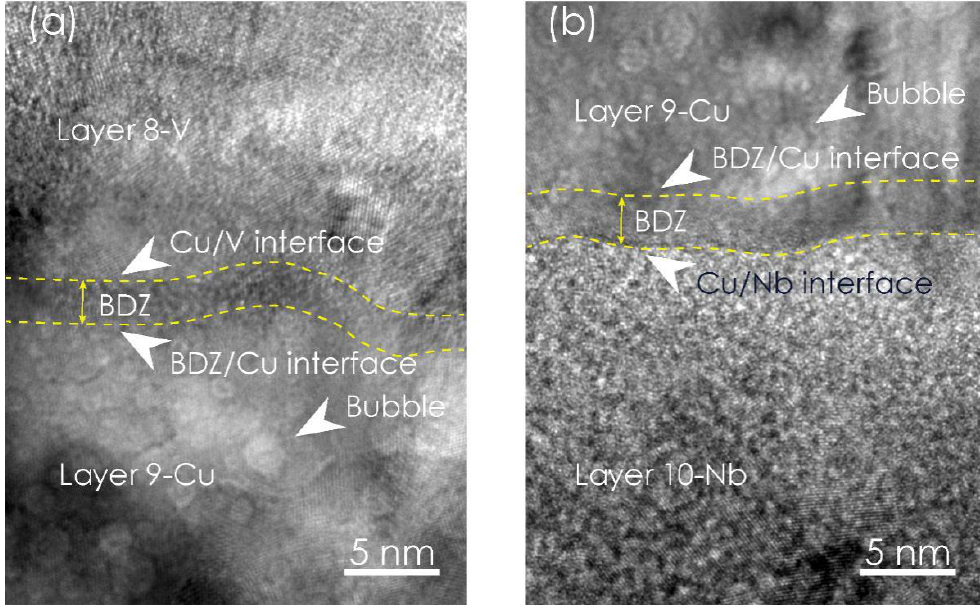
Figure 3. The typical HRTEM images of ( a ) the Cu/V interface sandwiched by the 8th V layer and the 9th Cu layer and ( b ) the Cu/Nb interface sandwiched by the 9th Cu layer and the 10th Nb layer in the irradiated Cu-Nb-Cu-V 48 nm NMMC at room temperature with a dose of 6 × 10 16 ions/cm 2 . The average width of the bubble denuded zone near the Cu/V interface in the 9th Cu layer is 2.5 ± 0.2 nm, while 3.5 ± 0.3 nm near the Cu/Nb interface in the 9th Cu layer. Bubbles are indicated by arrows.